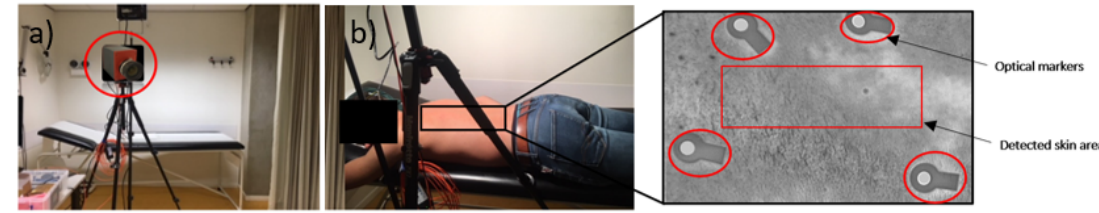
Figure 4. ( a ) Experimental set-up view, where the hyperspectral camera and the light source are mounted on a tripod. ( b ) The back of the subject is scanned by using optical markers as references (see the magnified view